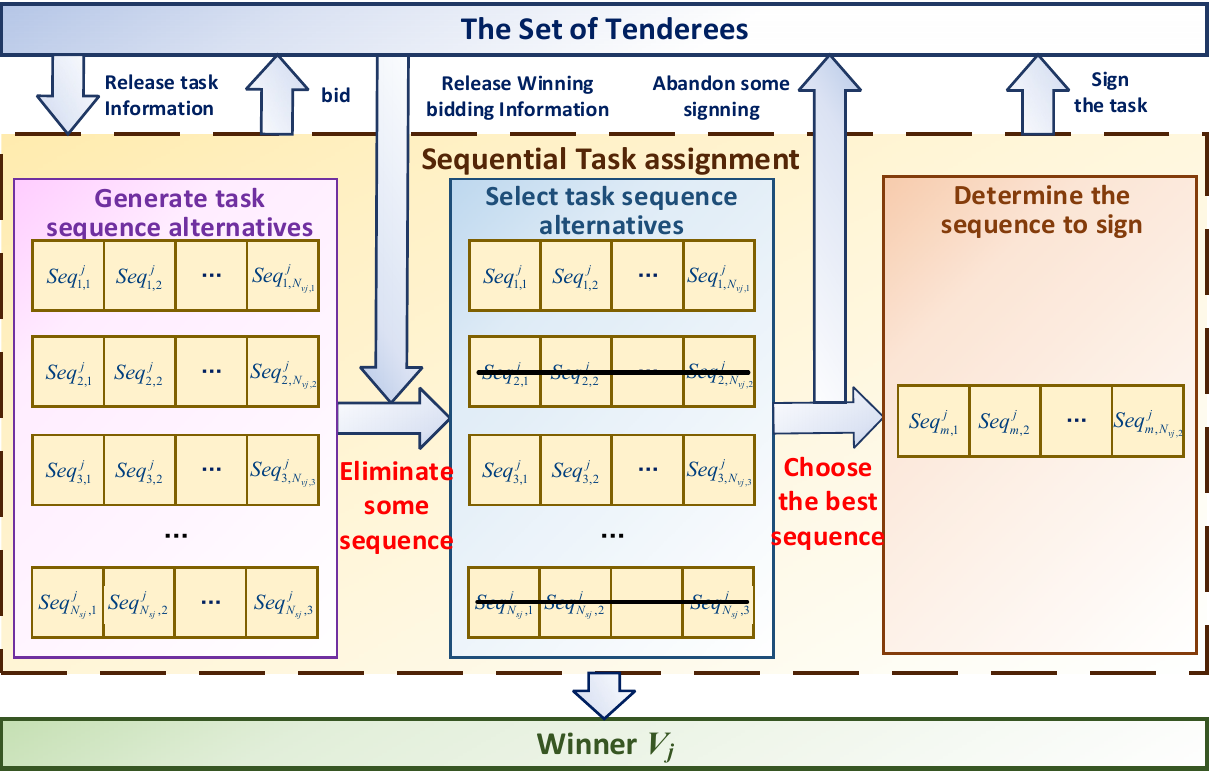
Figure 5. The process of task assignment based on extended CNP.